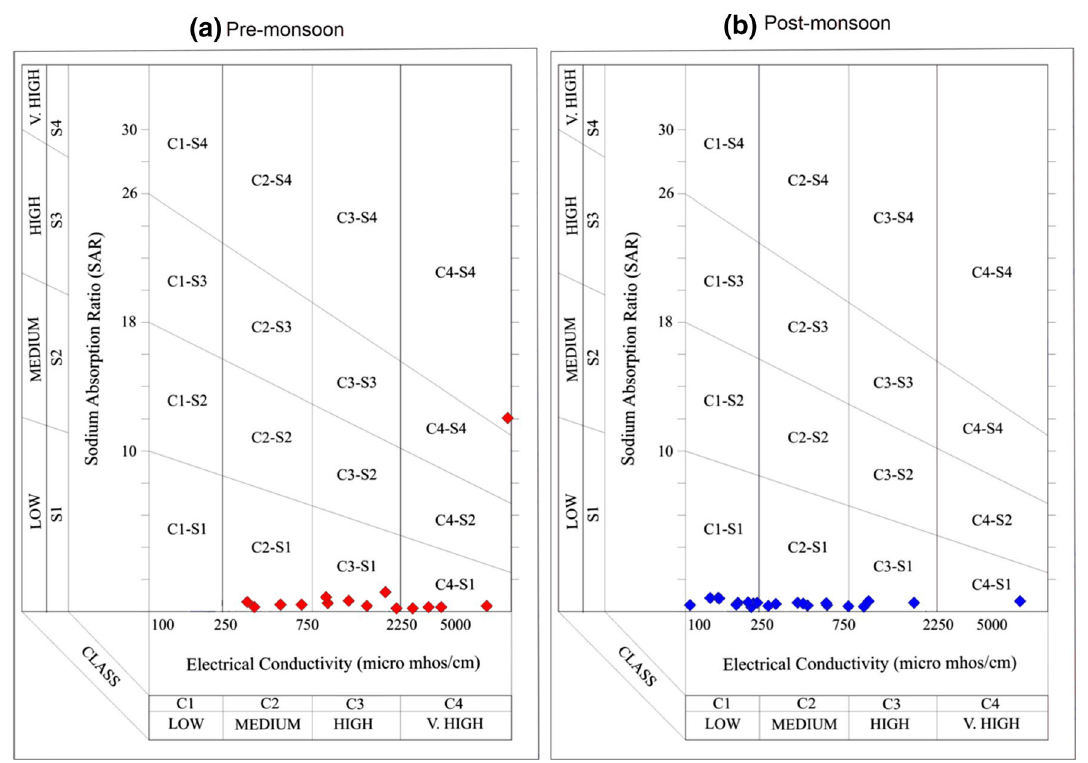
Fig. 9 US salinity diagram; a PrM; b PoM (after Richards 1954)